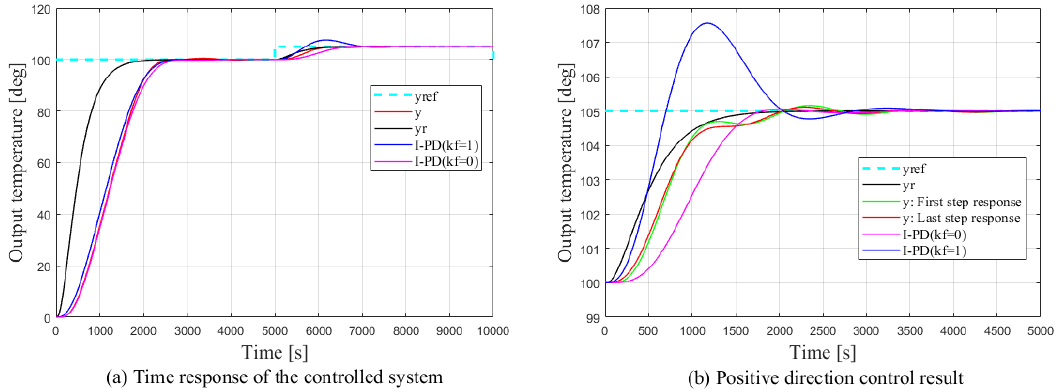
Figure 7. Simulation results. ( a ) Time response for the controlled system and ( b ) results of positive direction control for proposed control system and conventional I-PD control system for temperature increase from 100 ◦ C to 105 ◦ C obtained from